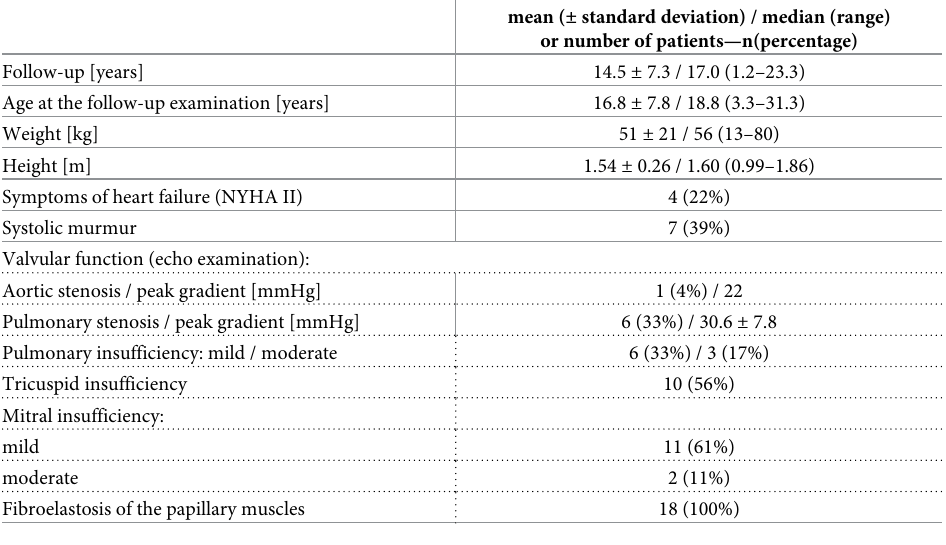
Table 1. Clinical data and valvular function of the study population at last follow-up (n = 18).